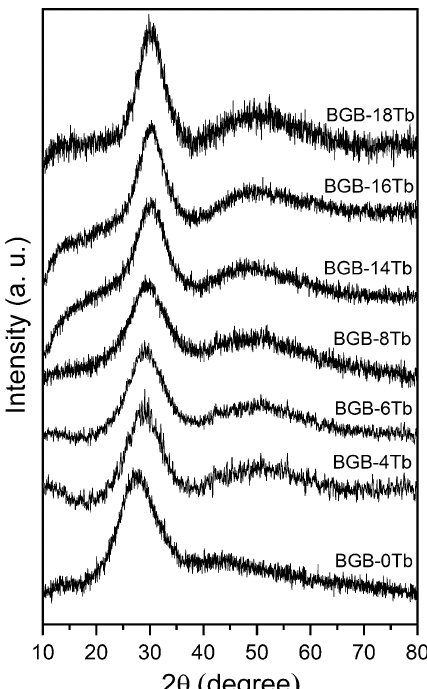
Figure 3. XRD patterns for the BGB- x Tb glasses.